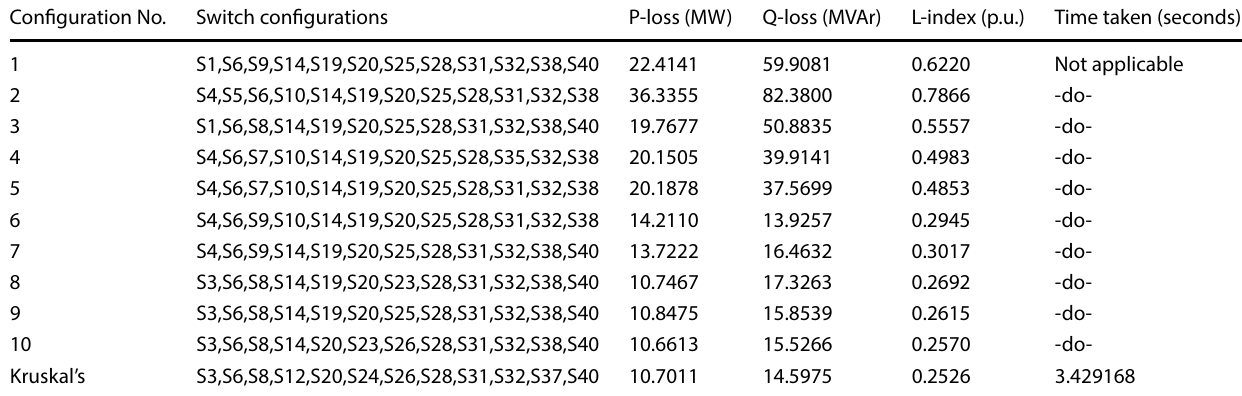
Table 6 Calculated values of L-index, P-loss, and Q-loss at 70% of base load Configuration No.